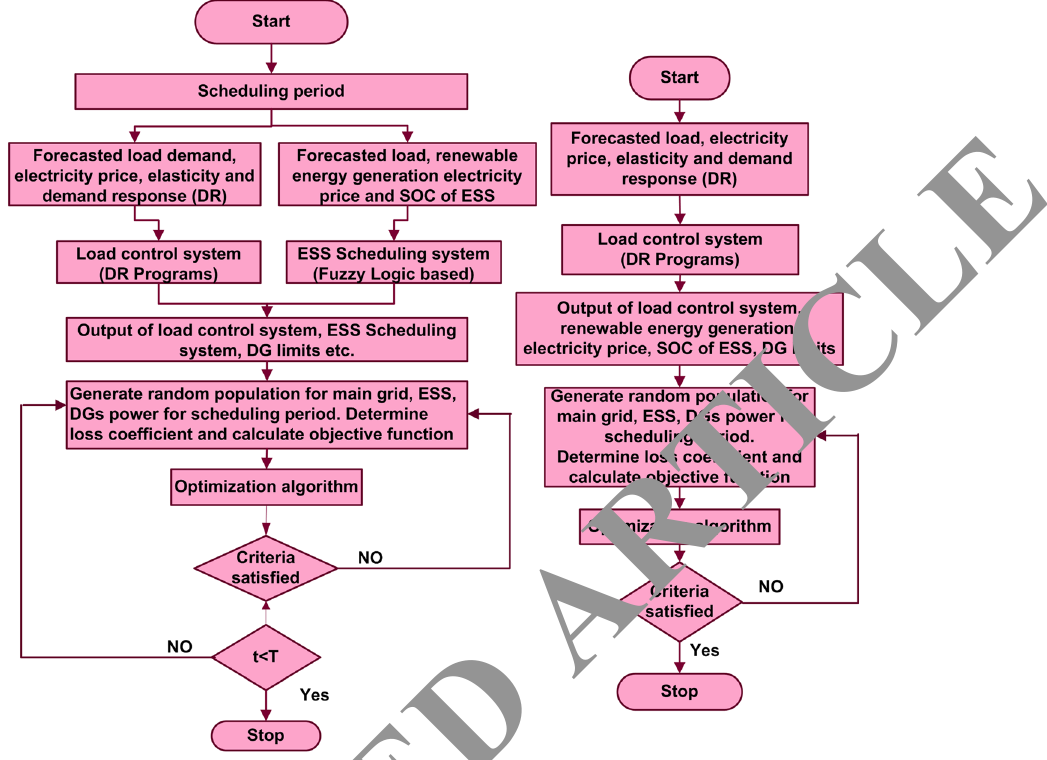
Fig. 3 Flow chart for microgrid energy management